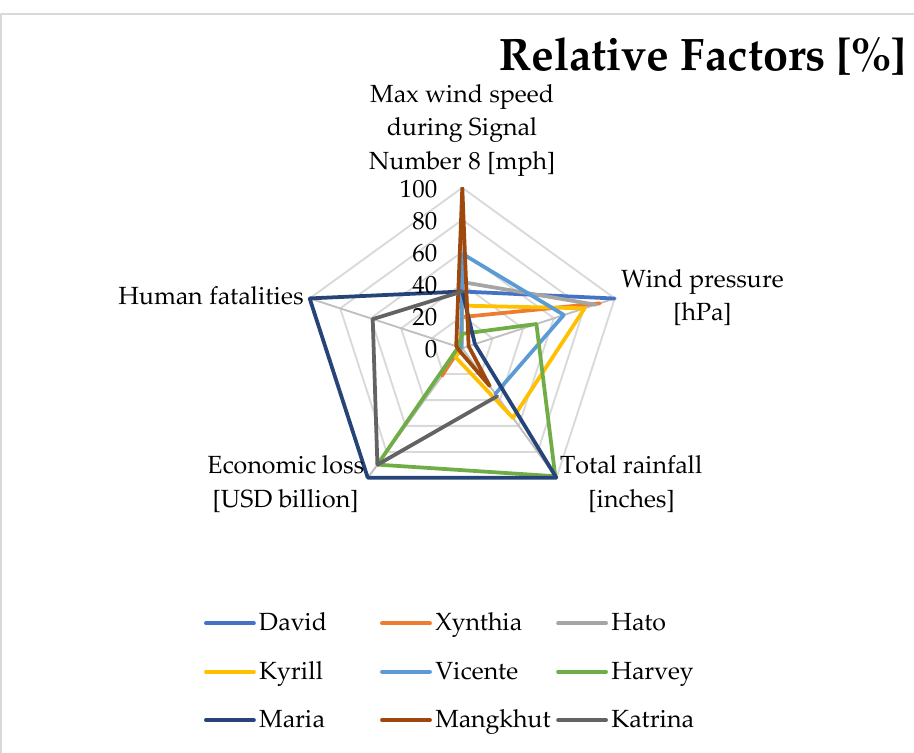
Figure 5. Summary of tropical cyclones in the USA, Europe, and Asia.